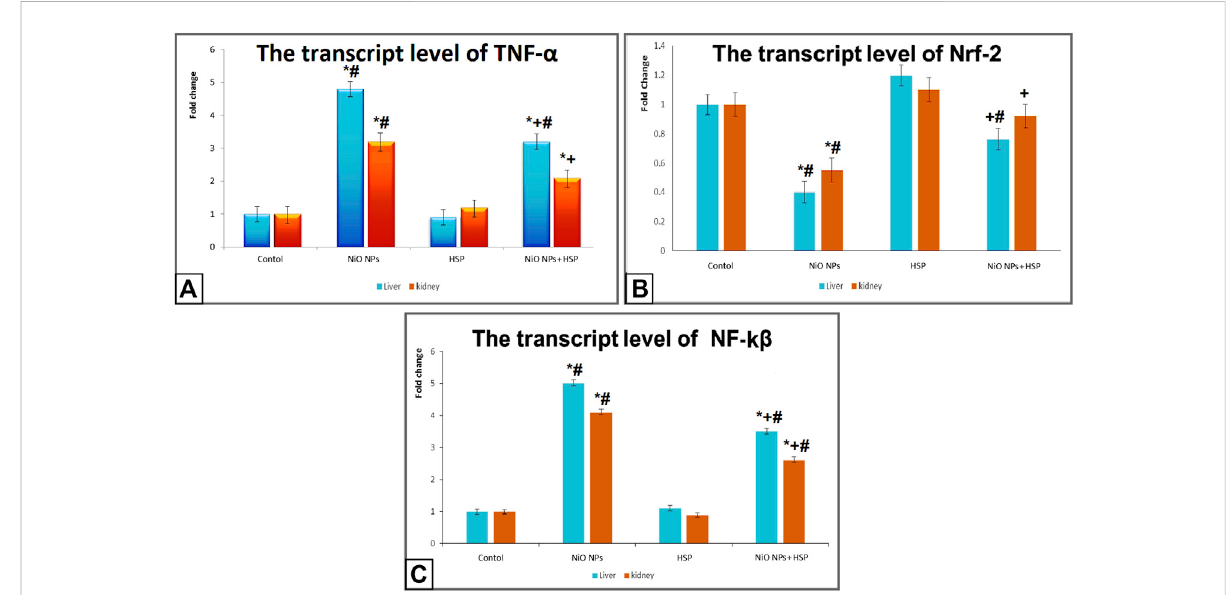
FIGURE 5 TheeffectsofNiO-NPsand/orHSPexposureonthetranscriptlevelsofTNF- α (Fig.5A) ,Nrf-2 (Fig.5B) ,andNF- ĸ β (Fig.5C) intheliverandkidney of rats. Values are presented as mean ± SD ( n = 10 rats/group). * : Signi fi cantly different from Control group. +: Signi fi cantly different from NiO-NPs group. #: Signi fi cantly different from HSP group. Statistical signi fi cance level at p < 0.05